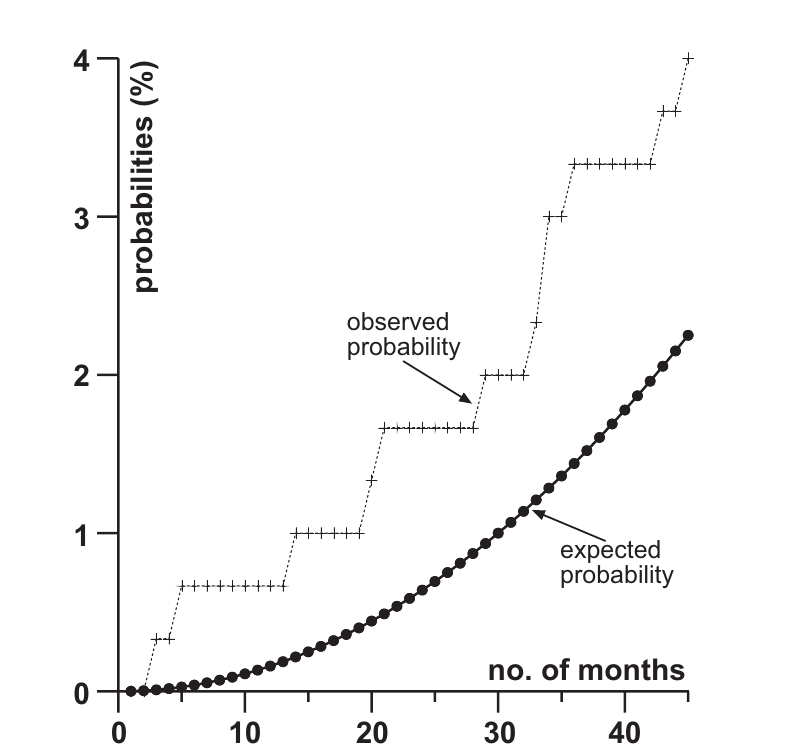
Fig. 5 . Expected and observed probabilities of concurrence of months with the greatest monthly totals of seis- mic moment (T M 0 ) for the Aeolian and Etnean areas (table V). For a number of months greater than 45, the di- vergence between the expected and observed probabilities